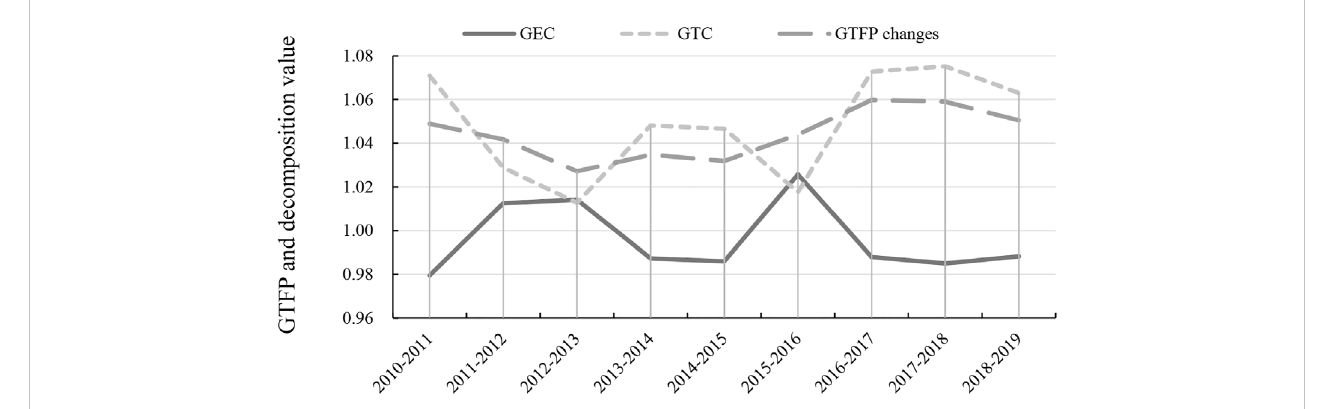
FIGURE 2 Changes of GTFP and decomposition value in urban agglomerations from 2010 to